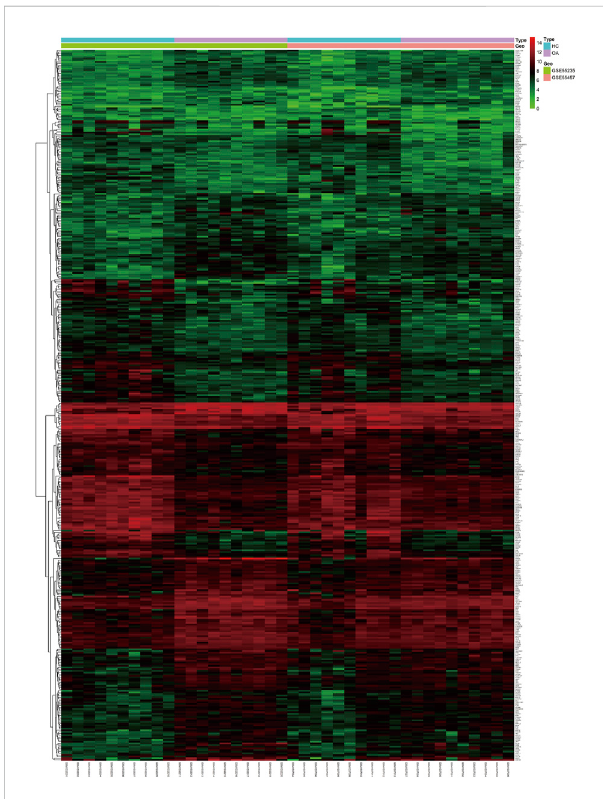
Heatmap of DEGs from two GEO datasets between healthy control and osteoarthritis patients. HC: healthy control; OA: